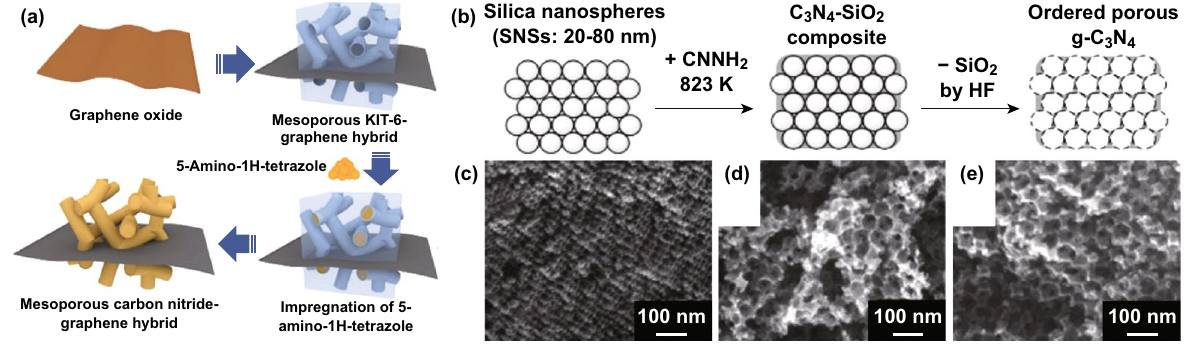
Fig. 12 a Schematic representation of the synthesis protocol for synthesizing the mesoporous C 3 N 5 and its graphene hybrid. Reproduced with permission from Ref. [98]. b Schematic illustration of the synthesis of ordered porous g-C 3 N 4 by using close-packed silica nanospheres (SNSs) as the primary template. c – e FE-SEM images of porous g-C 3 N 4 at different resolutions. Reproduced with permission from Ref. [93]. Copyright permissions from Wiley–VCH and Royal Society of Chemistry. (Color figure